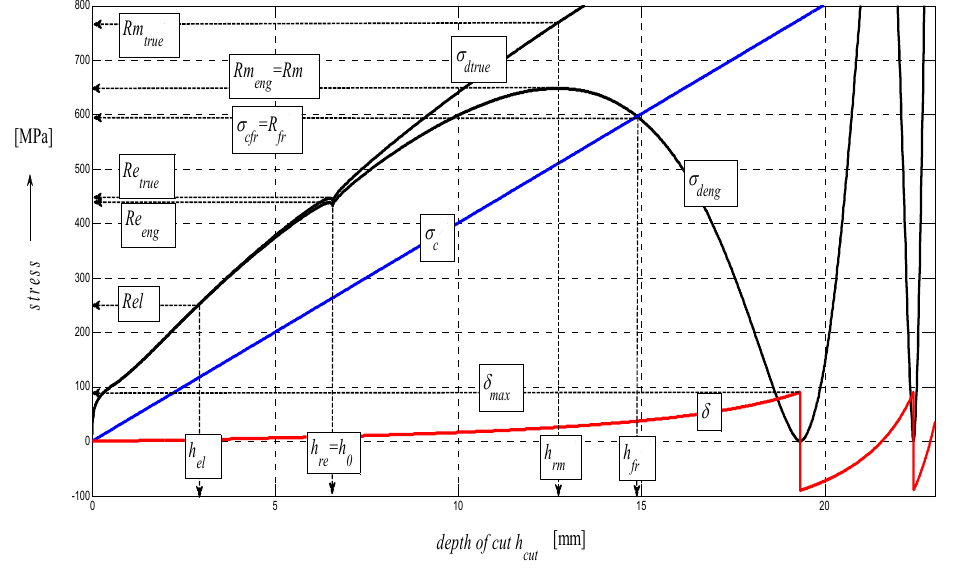
Figure 11. Diagram for EN S355J0 steel, dependence of functions on absolute depth.